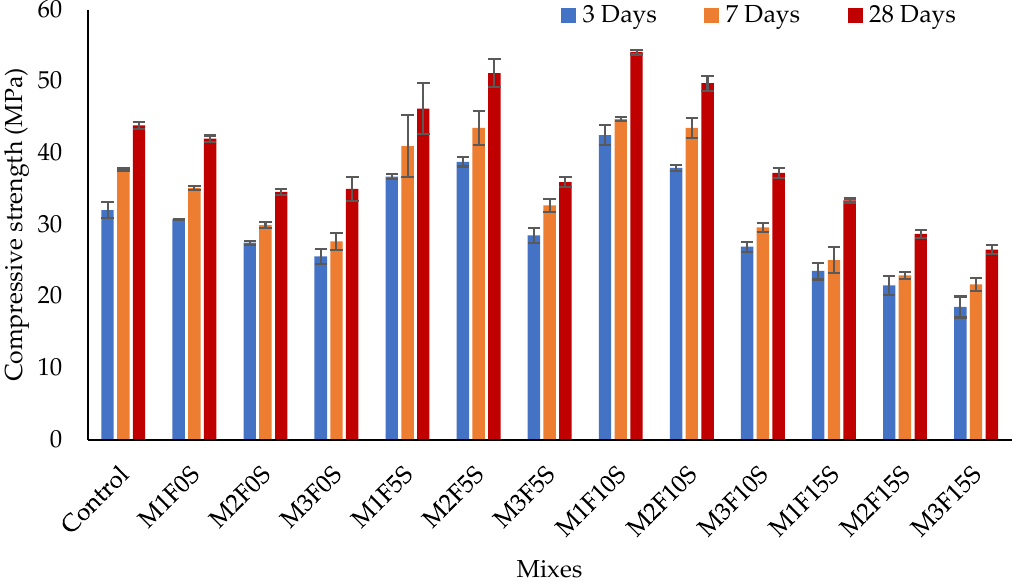
Figure 8. Compressive strength results.